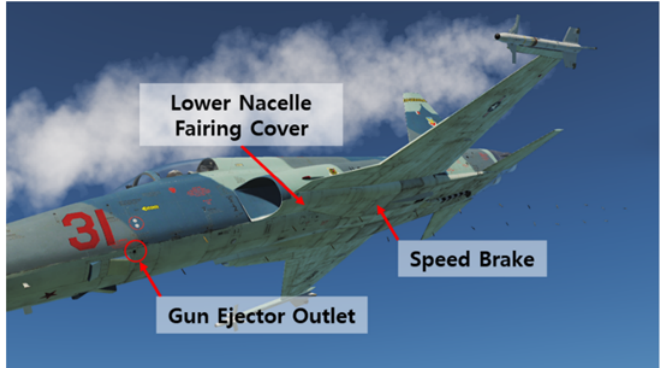
Figure 2. Photograph showing locations of damage to the gun ejector outlet, lower nacelle fairing cover, and speed brake.